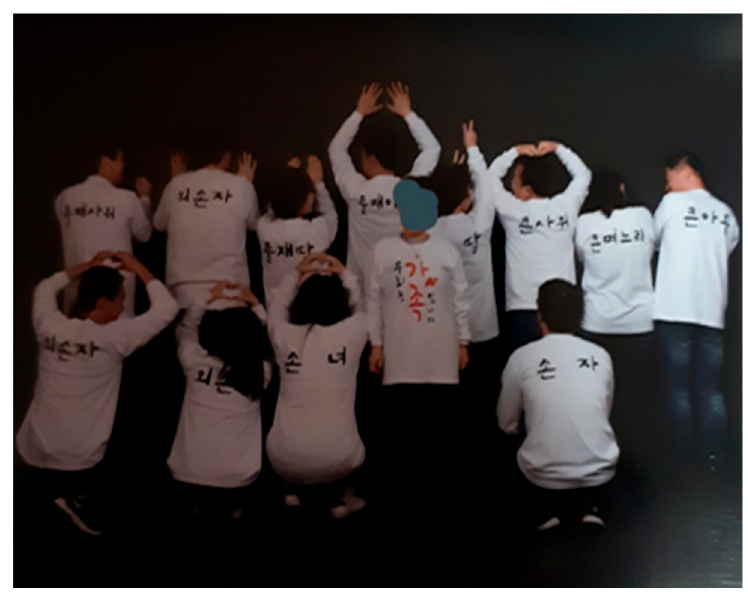
Figure 2. Meaning of weight management for breast cancer patients.